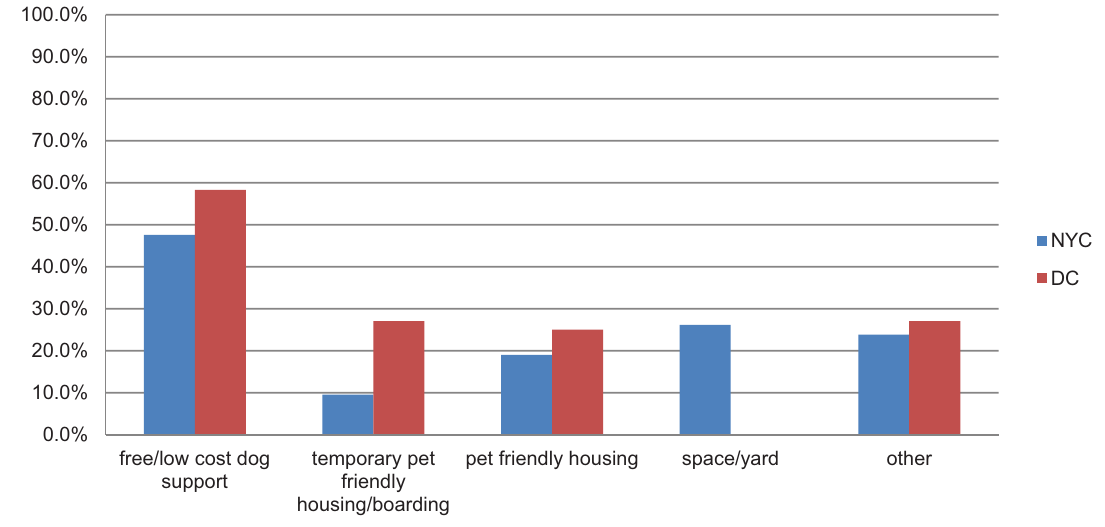
Figure 4. Comparison of resources, identified by relinquishers, which may have prevented surrendering of large dogs to shelters in New York City and Washington, D.C.